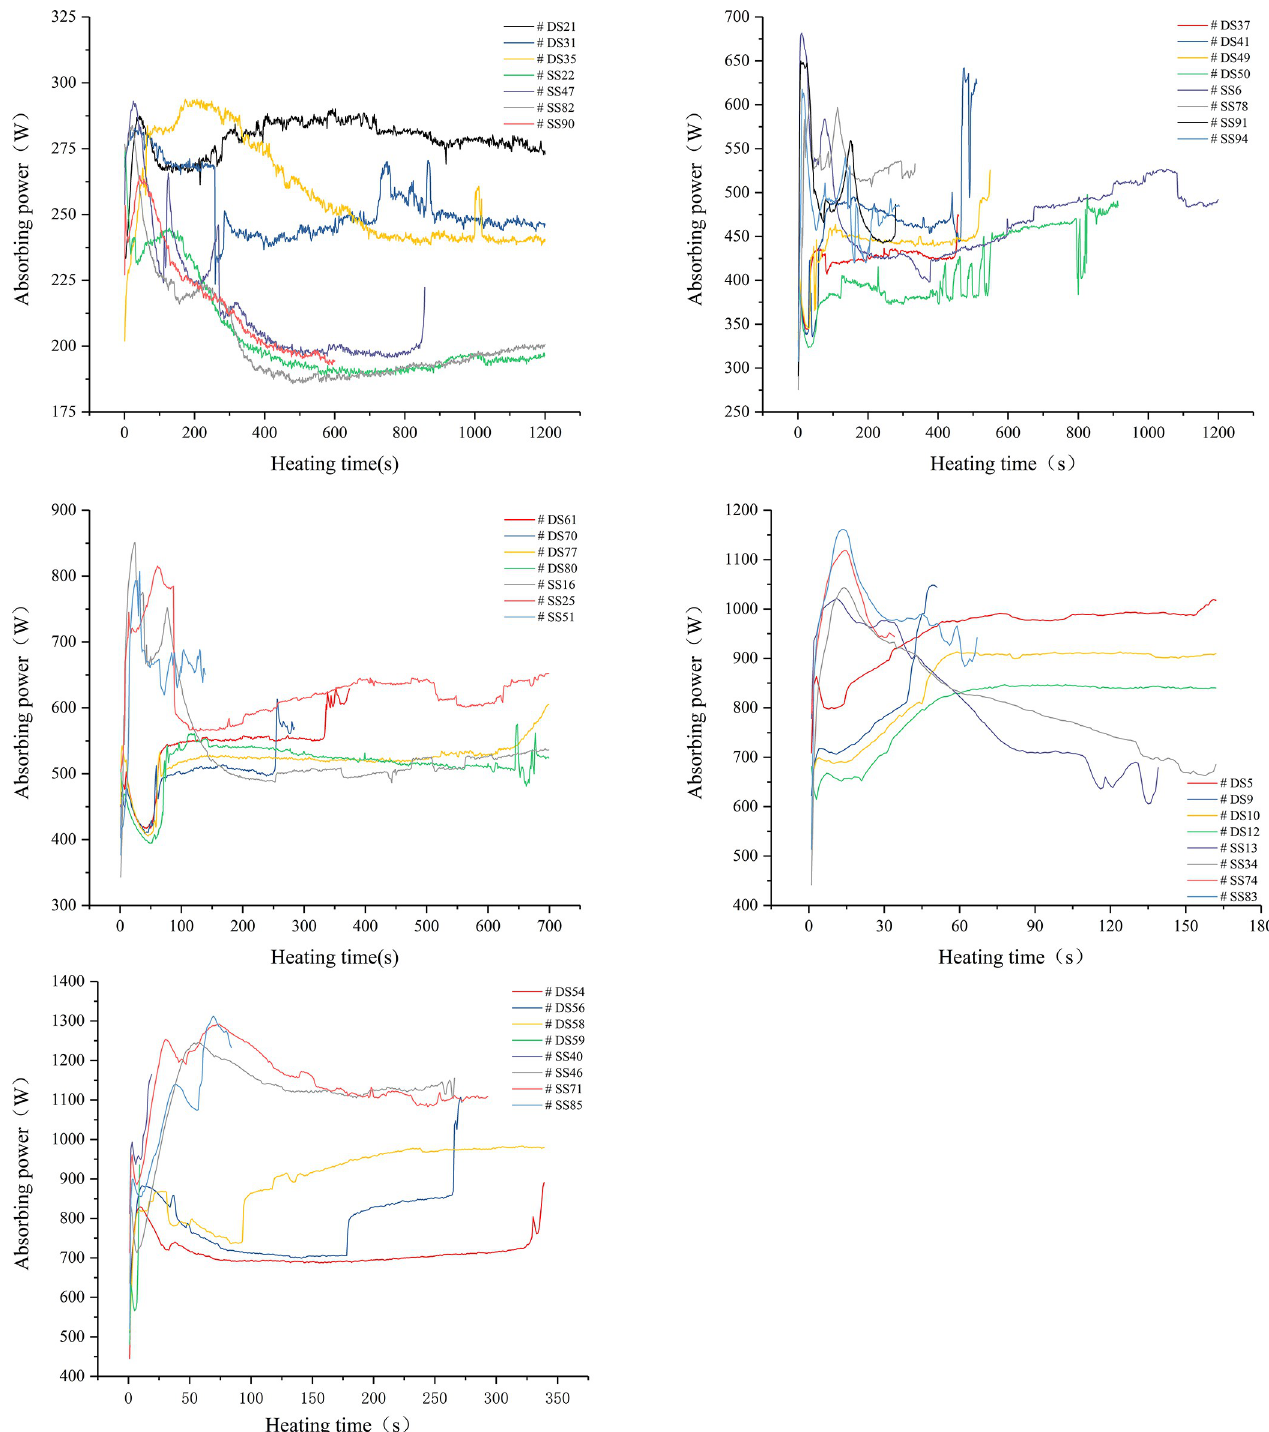
Fig 8. Absorbing power of coal samples under different output power. a, b, c, d, e are curves with output power equal to 1, 1.5, 1.8, 2 and 2.5 kW, respectively. (Note: DS stands for dry sample, SS stands for water-saturated sample).